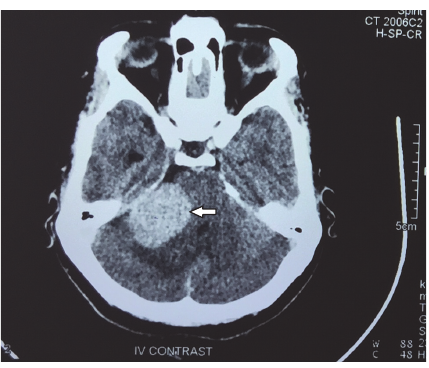
Figure 1: Contrast axial CT shows an ovoid homogeneous enhanc- inglesion(38 mm × 27 mm)involvingrightcerebellopontinecistern (white arrow).